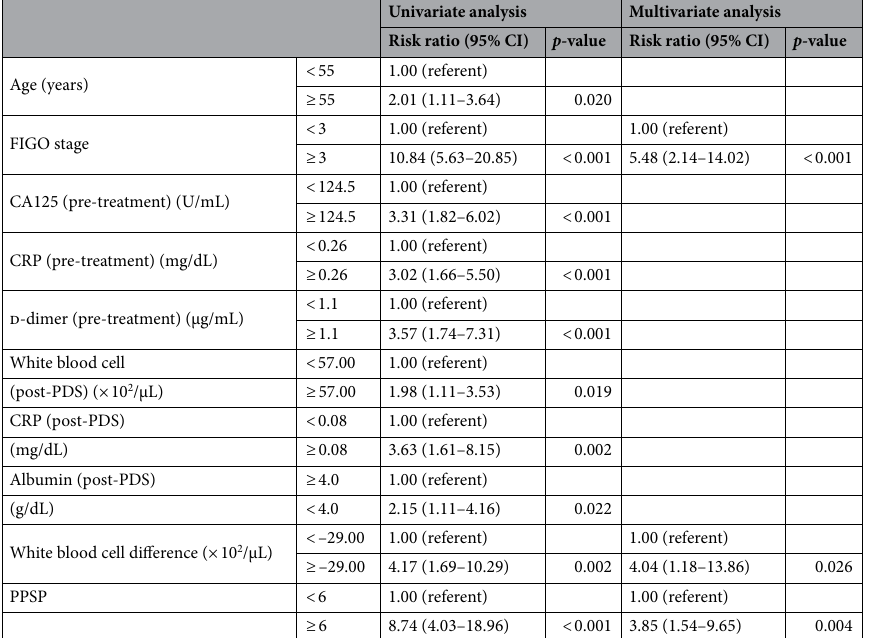
Table 5. Univariate and multivariable analysis of the predictive factors of recurrence. FIGO The International Federation of Gynecology and Obstetrics, CA125 carbohydrate antigen125, CRP C-reactive protein, PDS primary debulking surgery, PPSP prognosis predictive score around